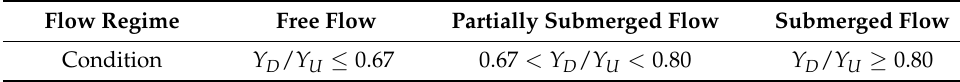
Table 1. HEC-RAS distinguishing range for sluice gate flow regimes [7]. Flow Regime Free Flow Partially Submerged